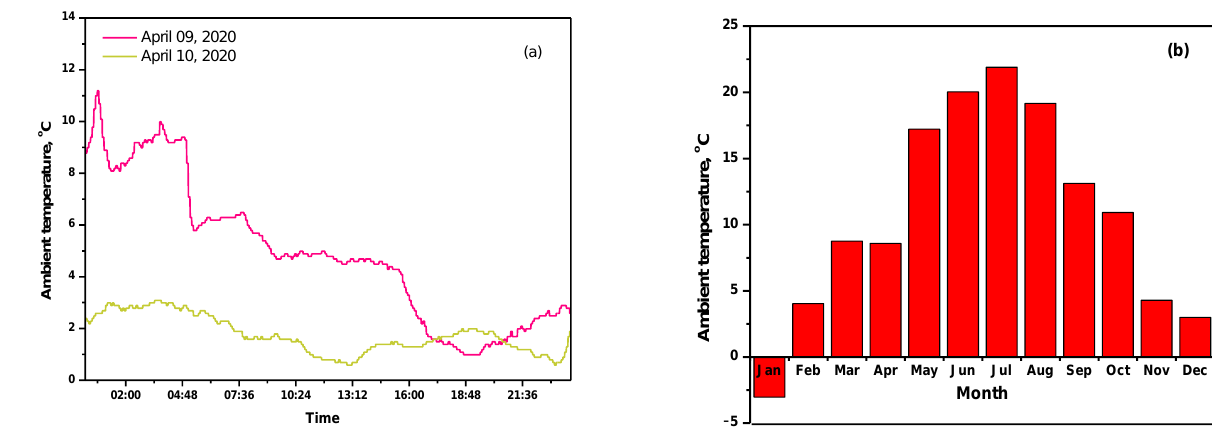
Figure 3. Ambient temperature for the 9 and 10 April of 2020 ( a ) and monthly averaged temperature ( b ).